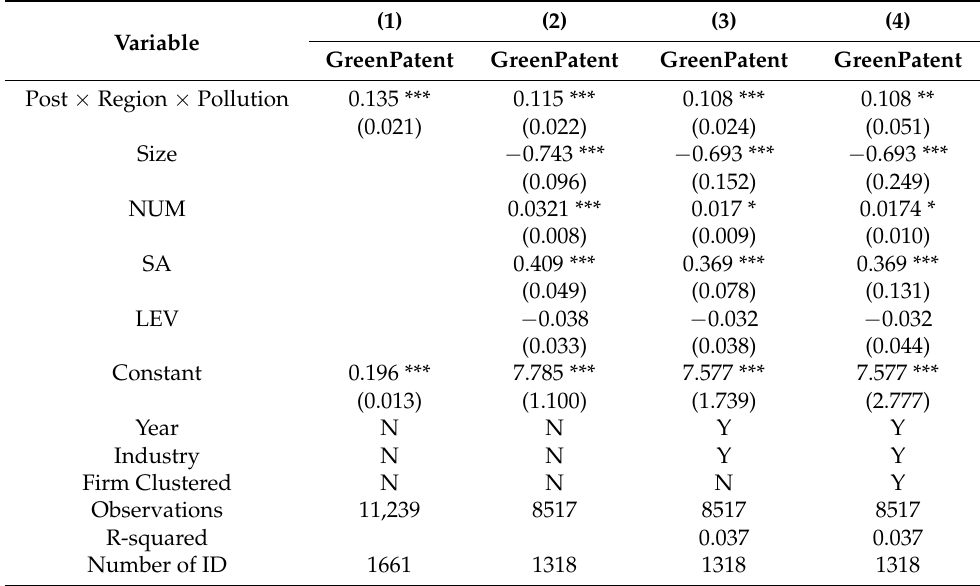
Table 8. Analysis of the heterogeneity of key regulatory